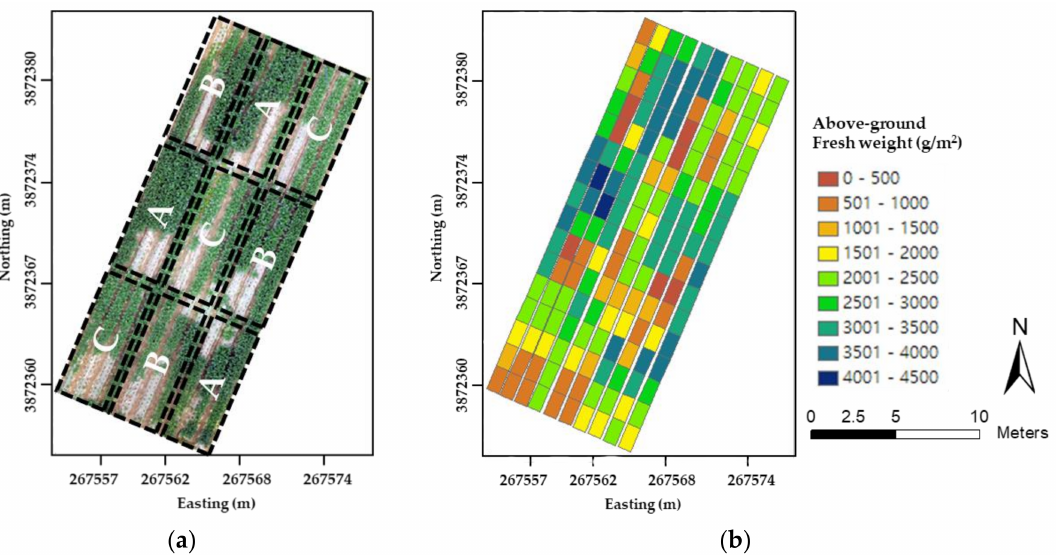
Figure 15. ( a ) Unmanned aerial vehicle-red, green and blue (UAV-RGB) orthomosaic image of white radish collected on 27 October 2016 and ( b ) above-ground fresh weight map of white radish generated using the developed regression models applied to the UAV-RGB image. The capital letters A, B, and C represent the subplots showing the growth of white radish planted on three different